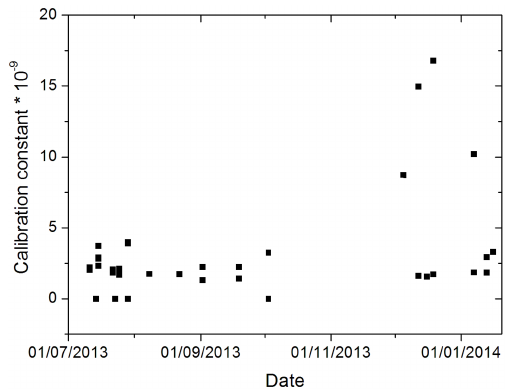
Figure 6. Variability of the calibration constant of the CS135s atten- uated backscatter coefficient profiles over the corresponding MUSA profiles. The period where no data are plotted corresponds to the an EARLINET intercomparison campaign in which MUSA was involved and moved for an intercomparison campaign in southern Italy (Wandinger et al.,